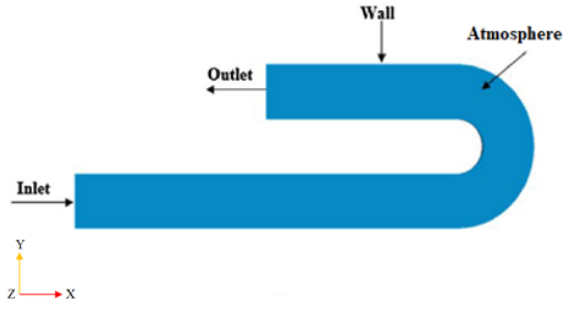
Figure 4. Boundary Figure 4 . Boundary conditions .